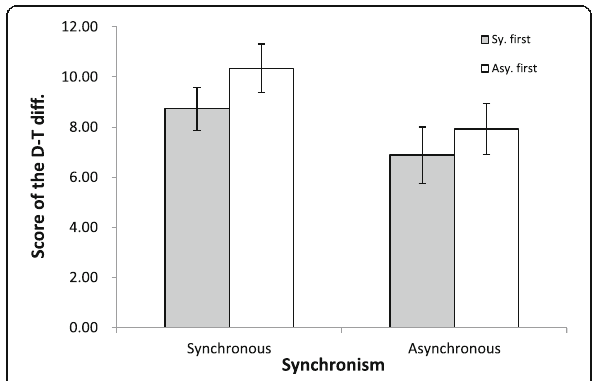
Fig. 2 Mean D-T diff. scores during the synchronous and asynchronous conditions for each order of presentation. Error bars represent the standard error of the